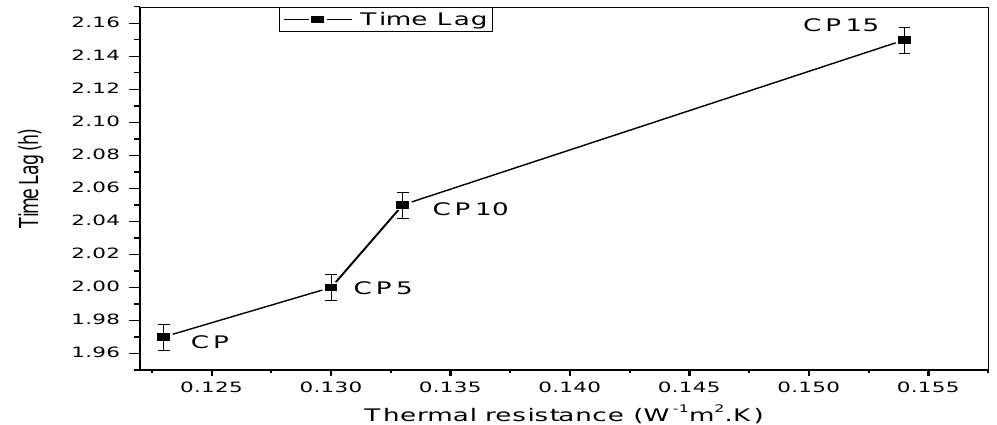
Figure 16. Time lag variation versus thermal resistance of